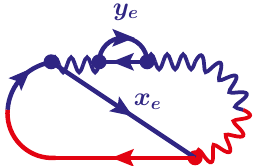
Figure 12 . A QED version [19] of the xyy (cid:22) x diagram of (cid:12)gure